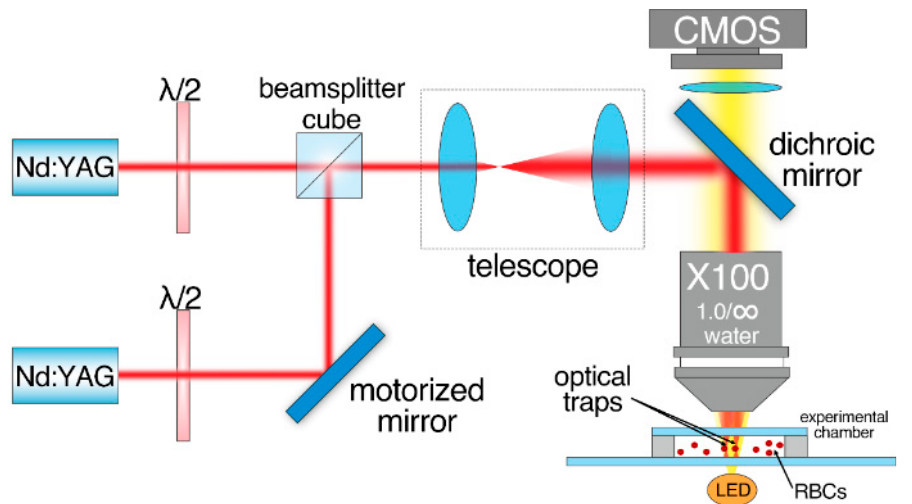
Figure 1. Schematic layout of the two-channeled laser tweezers (LT) used to measure interaction forces F int between two RBCs.